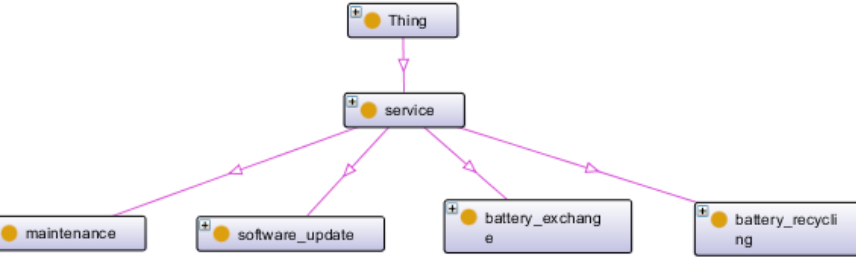
Figure 12. Overview of the service and its subtypes.